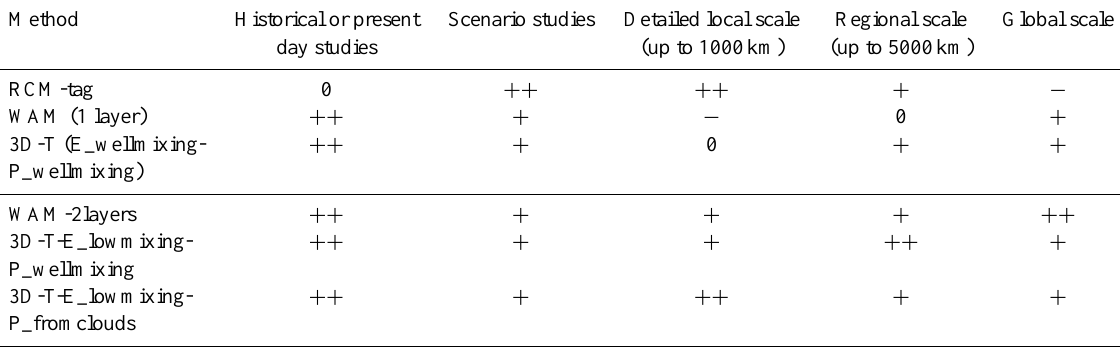
Table 3. Recommended suitability ∗ of methods considering both accuracy and computation speed. The choice for a method also dependents on location of the region (see Fig. 11), size of the tracer source area and available computational power (see Table 1).